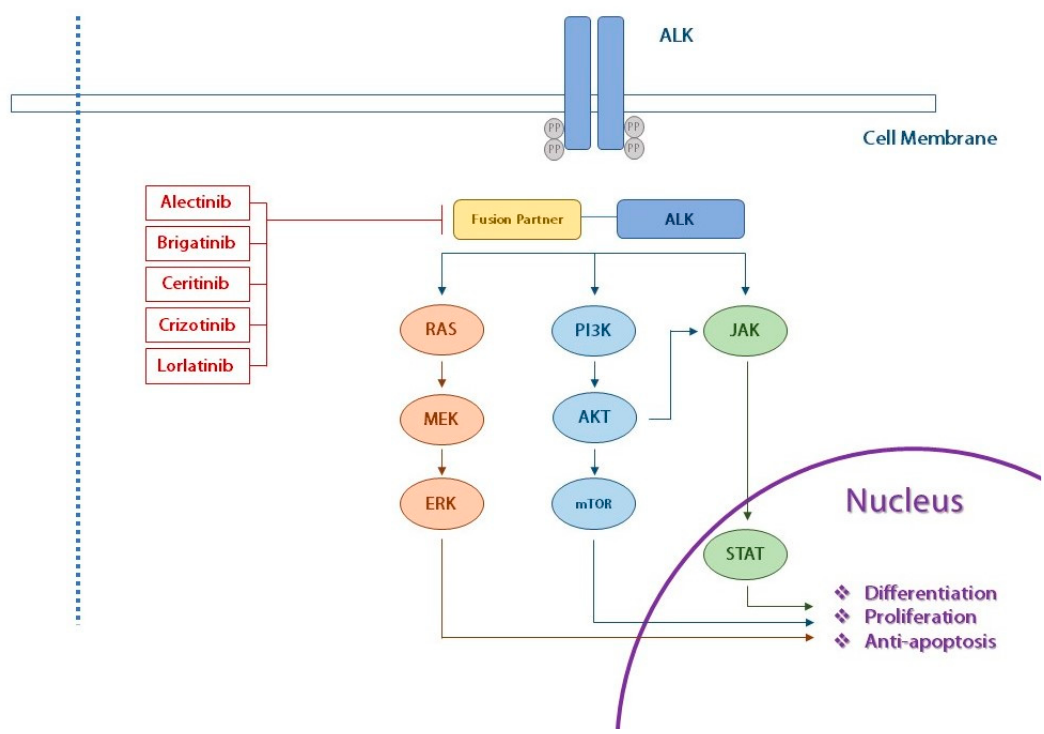
Figure 3. Illustration of ALK fusion oncogene with main downstream signaling pathways. Abbreviations: ALK—anaplastic lymphoma kinase; ERK—extracellular signal-regulated kinase; JAK—Janus kinase; mTOR—mammalian target of rapamycin; MEK—mitogen-activated protein kinase; PI3K—phosphatidylinositol 3-kinase; PP—pyrophosphate; AKT—protein kinase B; RAS—rat sarcoma virus; STAT—signal transducer and activator of transcription.